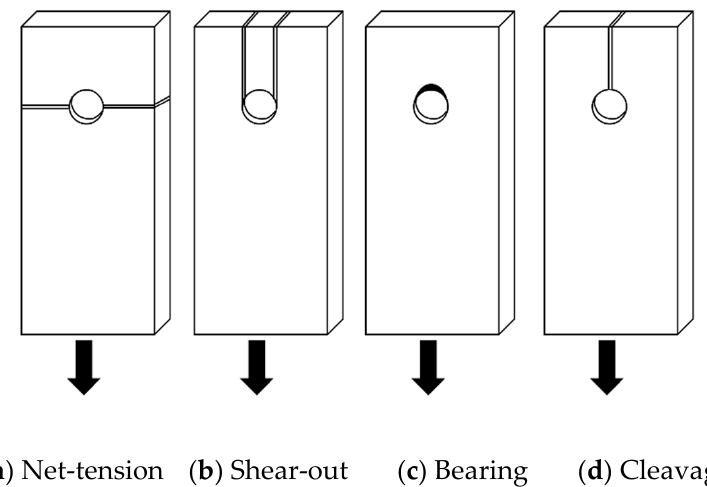
Figure 2. Failure Modes of Bolted Composite Plates.